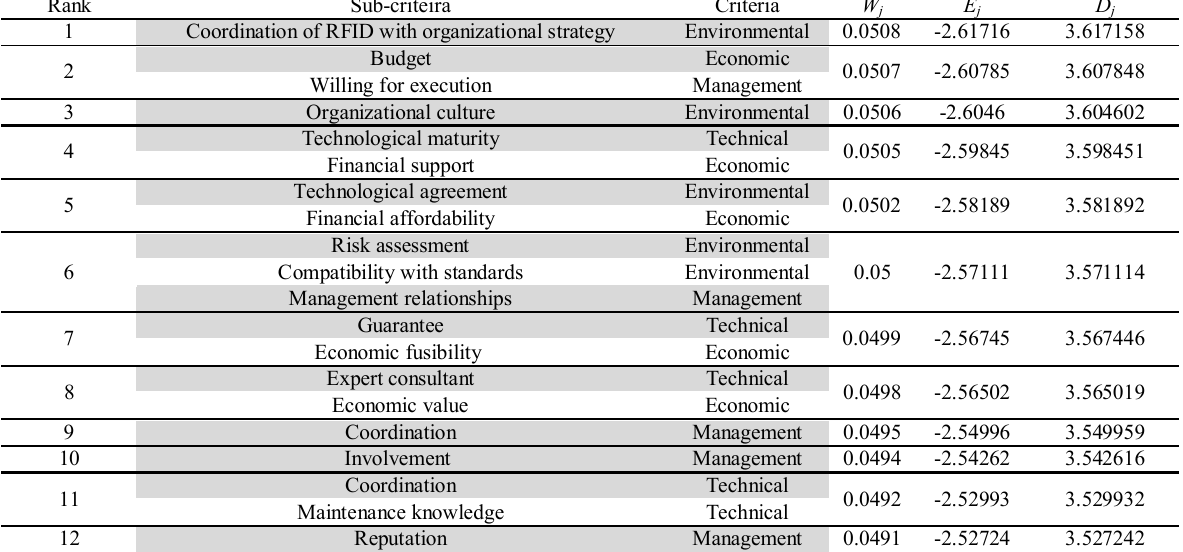
The summary of ranking for